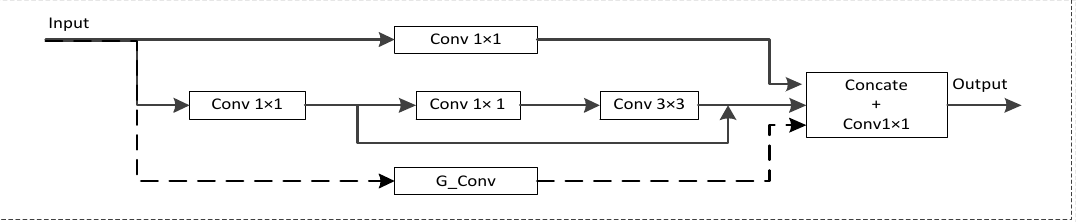
Figure 3. G-CSPNet module. G_Conv denotes large-scale convolution operation. The G_conv module is composed of a CNN, as shown in Figure 4. The 1 × 1 convolu- tion kernel is first used to change the size of the feature map from C × H × W to 1 × H × W, and a 9 × 9 convolutional network is then used to extract large-scale information from the feature map by using it in a cascade with the previous 1 × 1 convolutional network, called G_conv. This improves the performance of the detector by extracting large-scale information from the feature map while adding few parameters.